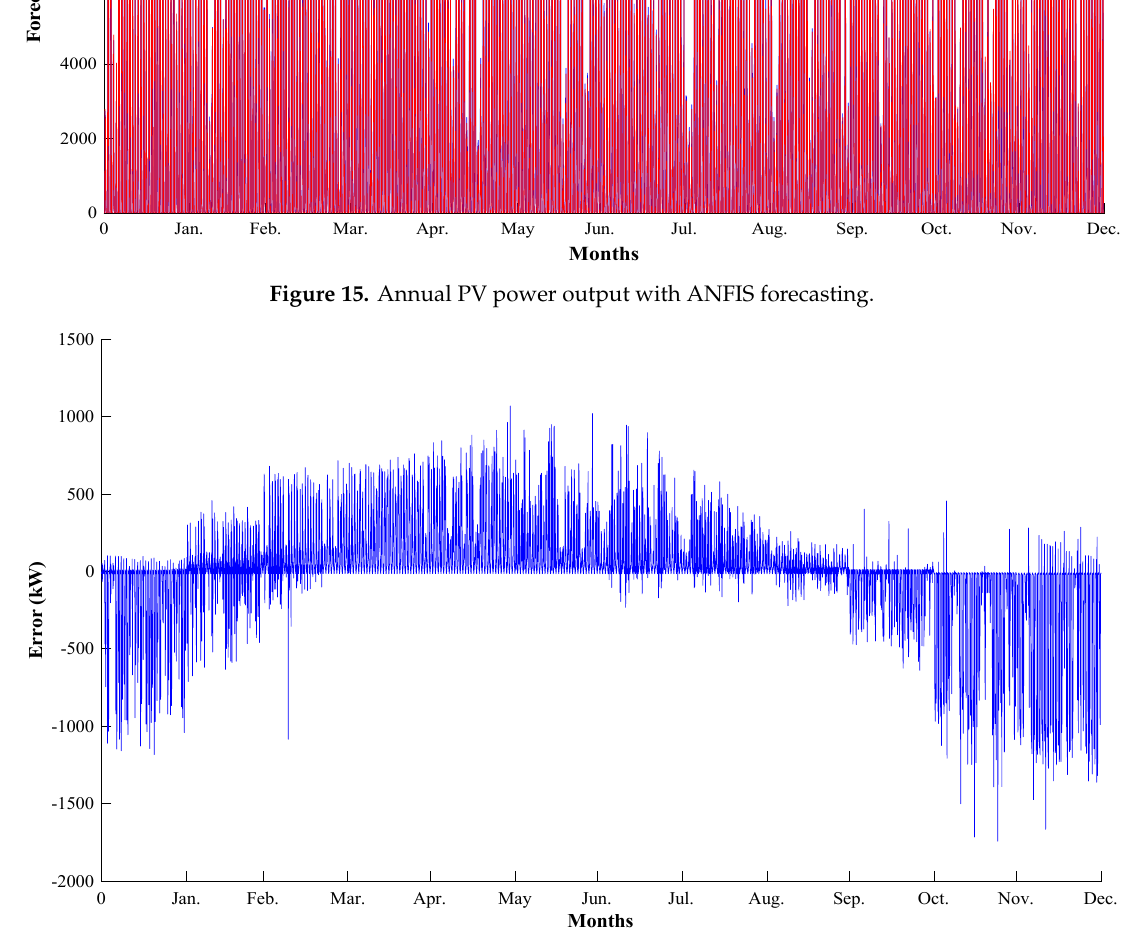
Figure 16. Annual power output error with ANFIS forecasting.